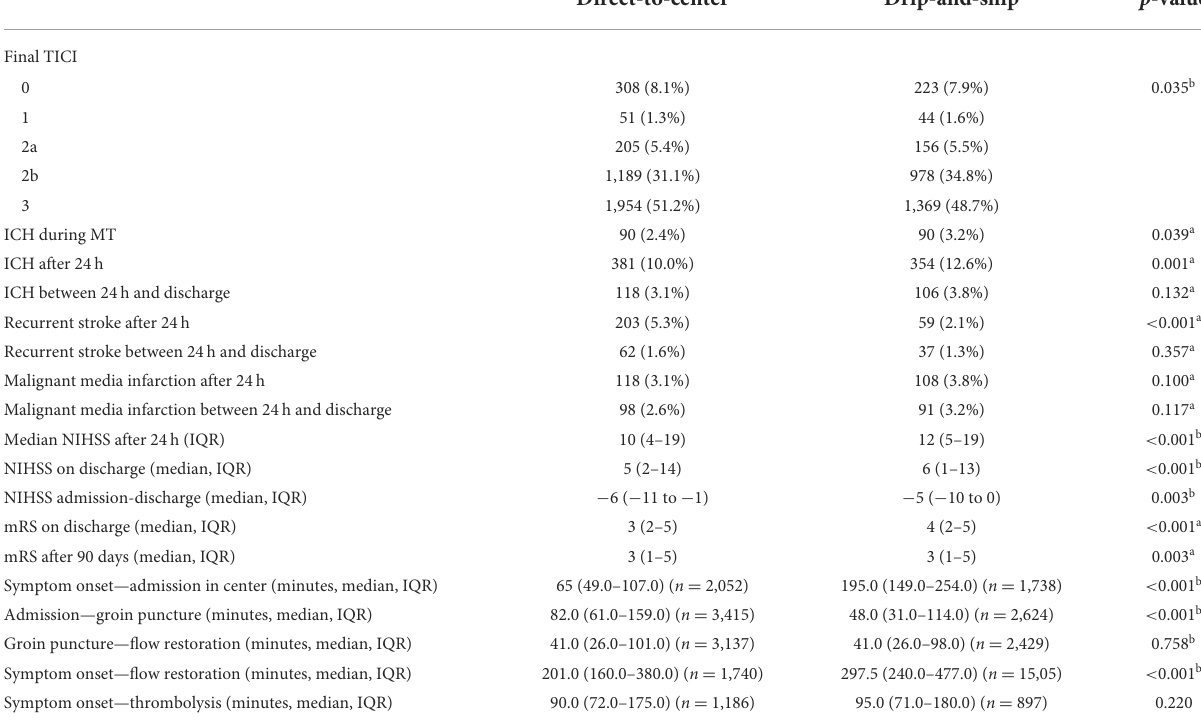
TABLE 3 Results from baseline characteristics, treatment procedures and outcome of direct-to-center and drip-and-ship patients after propensity score matching. Direct-to-center Drip-and-ship